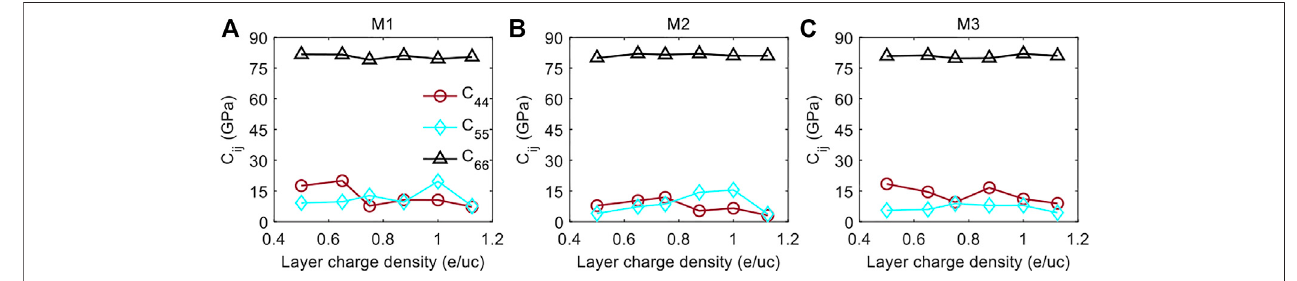
FIGURE 7 | The shear elastic constants C 44 , C 55 , and C 66 as a function of layer charge density for the (A) M1 Model, (B) M2 Model, and (C) M3 Model.